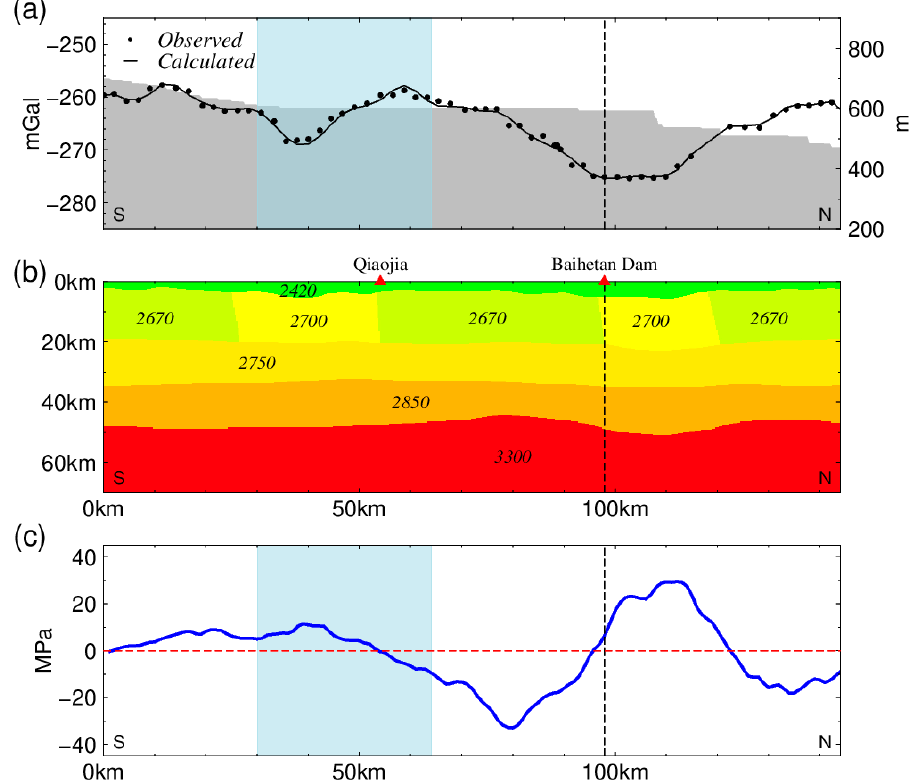
Figure 5. Bouguer Gravity Anomaly, crustal density structure and isostatic additional force (IAF) along the Baihetan reservoir. ( a ) Bouguer Gravity Anomaly and the Topography. ( b ) Density structure. ( c ) IAF borne by the lithosphere. The light blue area in ( a , c ) indicate the main storage area where the reservoir is wide. The red dotted line denotes the zero line of IAF, and the black dotted line denotes the dam.